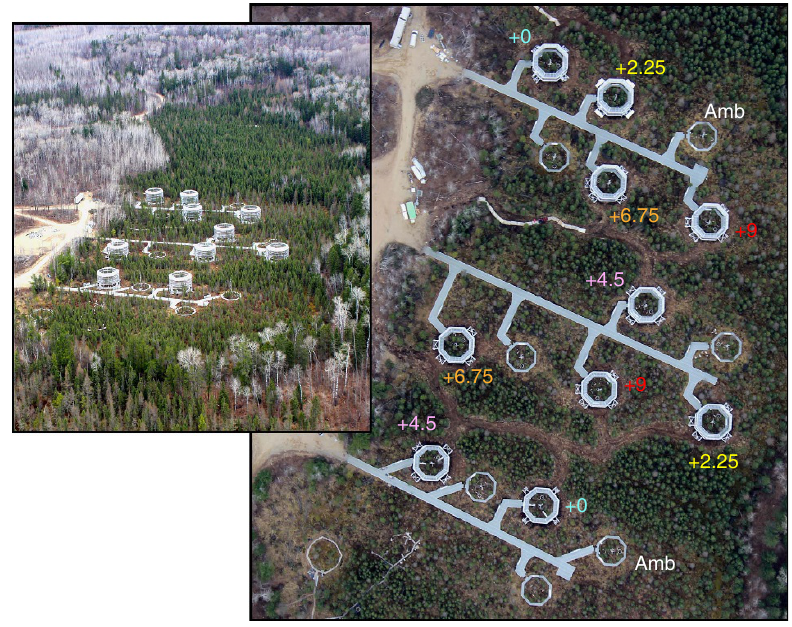
Figure 1 | Schematic of the SPRUCE site located in northern Minnesota. Three boardwalks transect the site, with experimental treatments plots branching radially off of those boardwalks. Numbers indicate the target temperatures, relative to ambient conditions, established within each enclosure. ‘Amb’ plots indicate that no temperature treatment has been added. Inset shows an aerial overview of the site with the experimental enclosures installed in the context of the surrounding